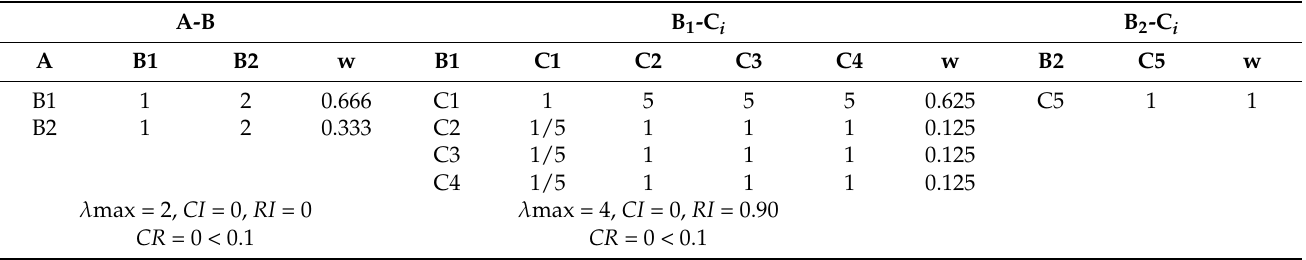
Table 5. Judgment